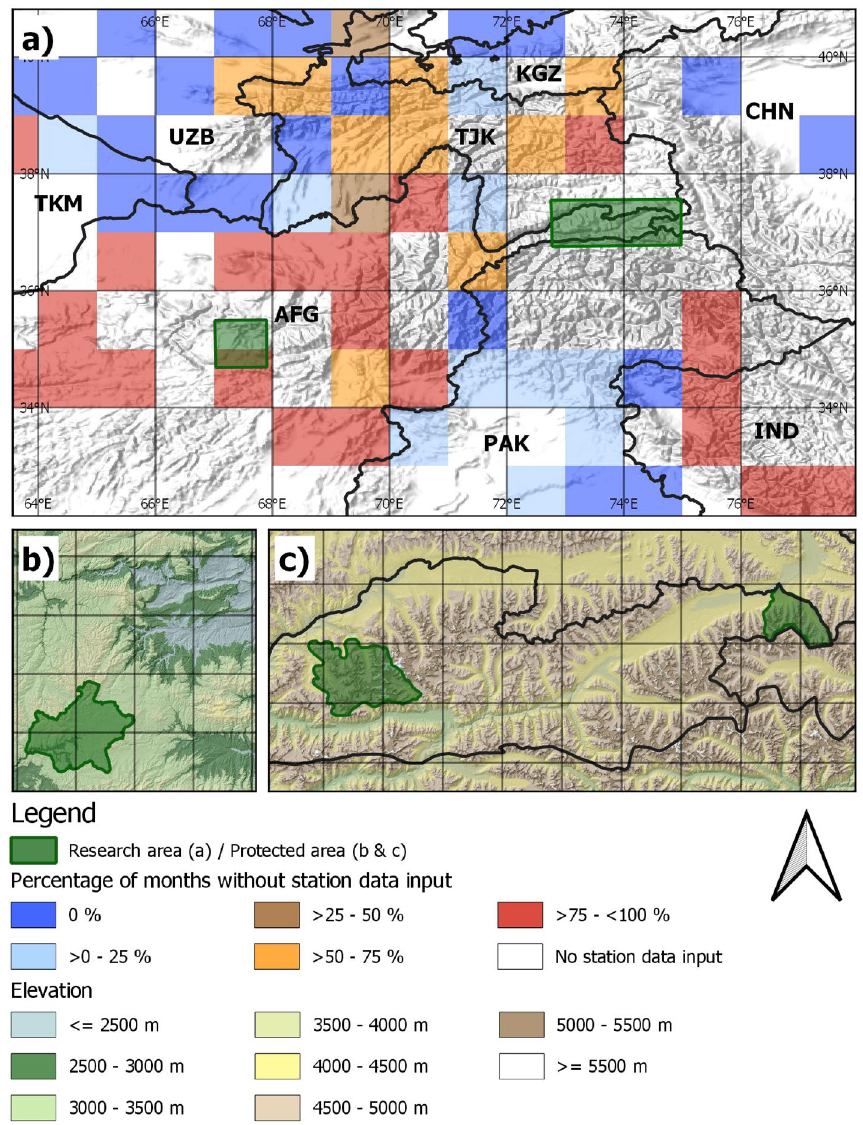
Figure 1. Overview of ( a ) the research areas with an overlay of missing station data in the GPCC Monitoring Product 2001–2018 (EPSG 4326), ( b ) the Band-e-Amir (EPSG 32642 with 20 km grid overlay), and ( c ) the Wakhan research areas (EPSG 32643 with 20 km grid overlay). Monthly missing station data in the lower Band- e-Amir cell is 98% (GPCC data: 39 , relief data: 43,44 ). Created using QGIS 3.12 (http://qgis.osgeo .org/) 45